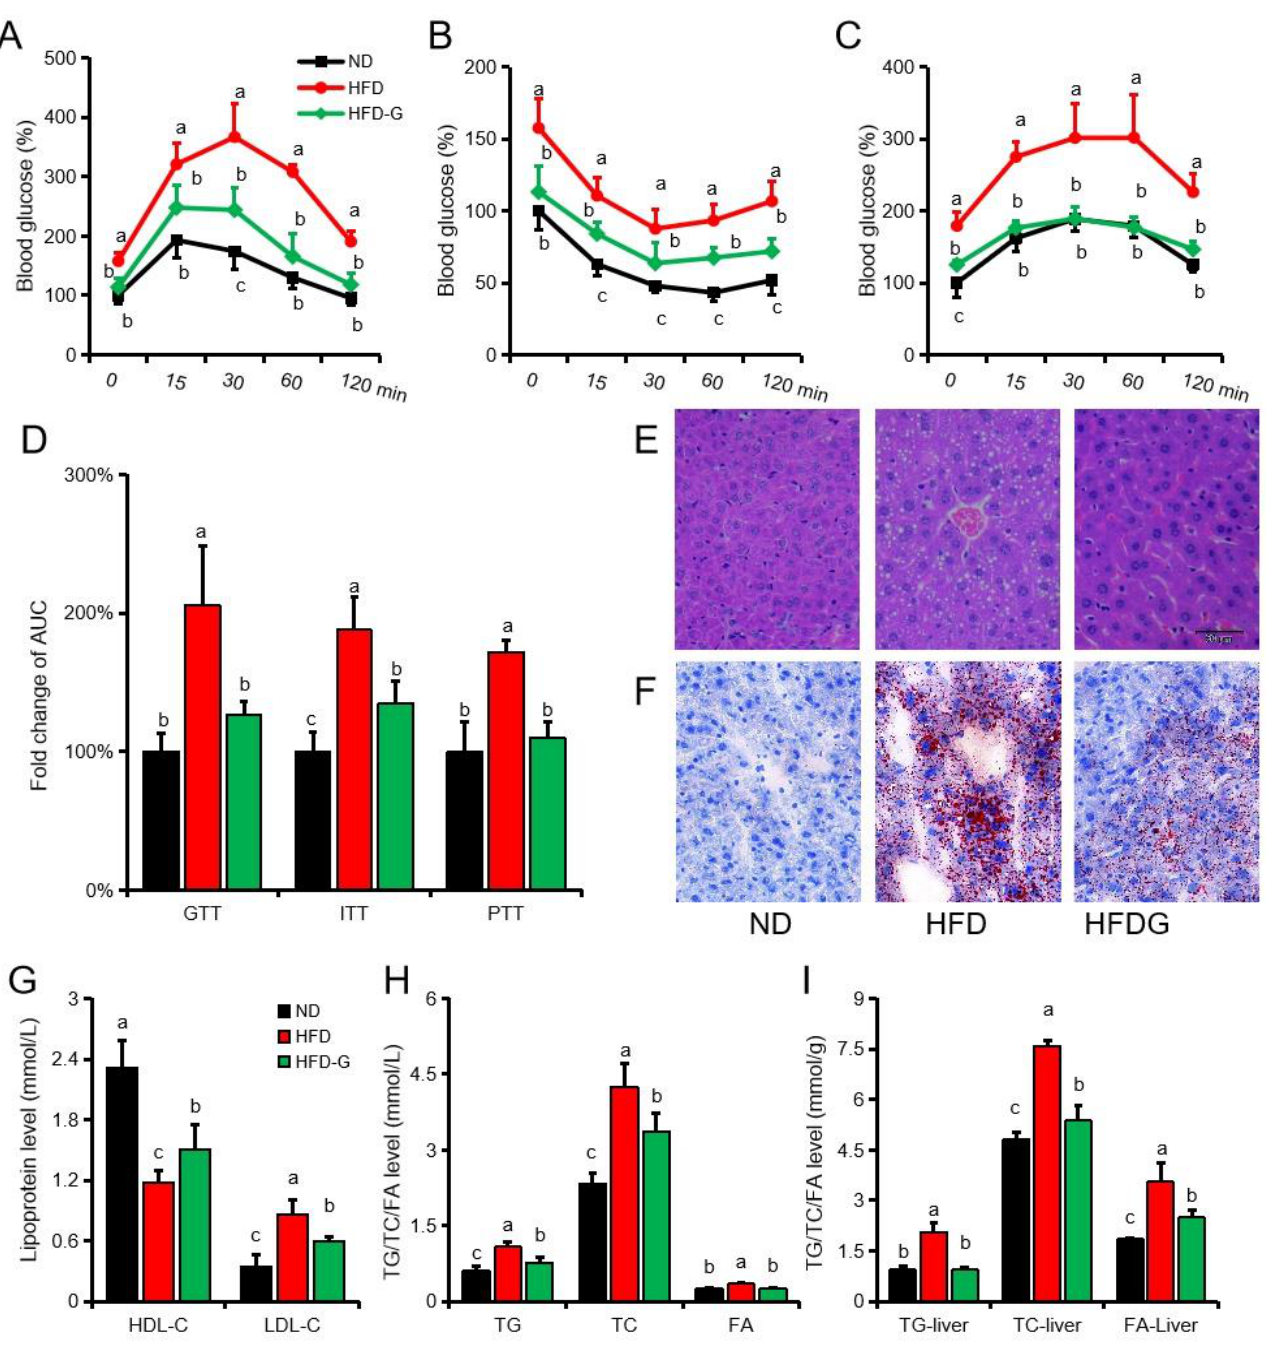
Figure 2. Genistein alleviates insulin resistance and hepatic lipid accumulation in obese mice. ( A ) GTT. ( B ) ITT. ( C ) PTT. ( D ) The area under the curve (AUC) of GTT, ITT and PTT. ( E ) HE staining of liver sections. ( F ) Oil Red O staining of liver sections (magnification, 200 × ). ( G ) Plasma HDL-C and LDL-C. ( H ) Plasma TG, TC and FA. ( I ) Triglycerides (TG), total cholesterol (TC) and free fatty acids (FA) in liver homogenate. n = 6. Different superscript letters indicate significant differences ( p ≤ 0.05), and the same superscript letters indicate insignificant differences ( p > 0.05).